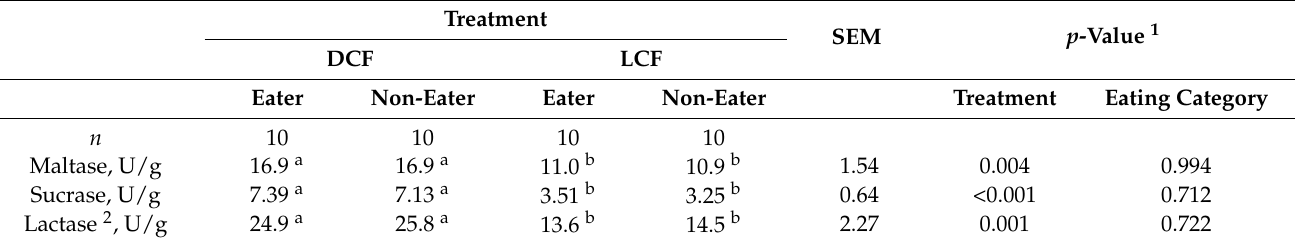
Table 5. The enzyme activity in the proximal part of the small intestine in pigs fed a dry (DCF) or liquid (LCF) diet and categorized into eating categories based on 3 fecal swabs. Eaters are defined by the presence of feed dye on 2–3 swabs whereas non-eaters never showed dye on the